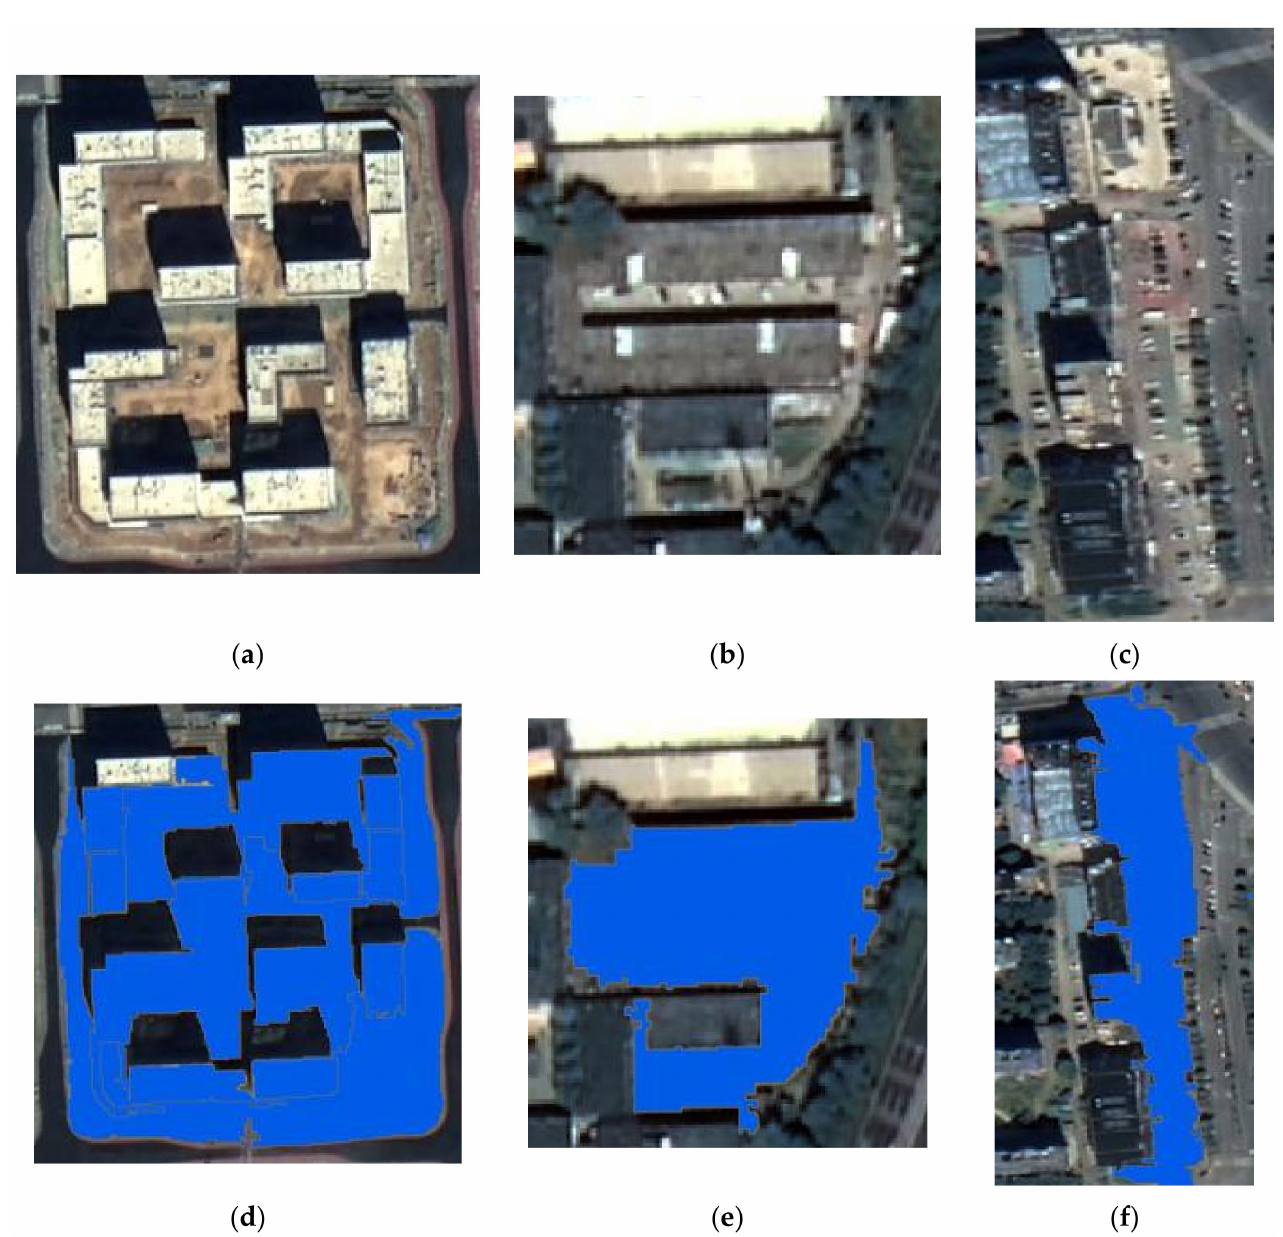
Figure 25. Classification results of the fifth band:( a – c ) are the original image comparison diagram, ( d ) a roadside car park, ( e ) the building under construction, ( f ) the building after